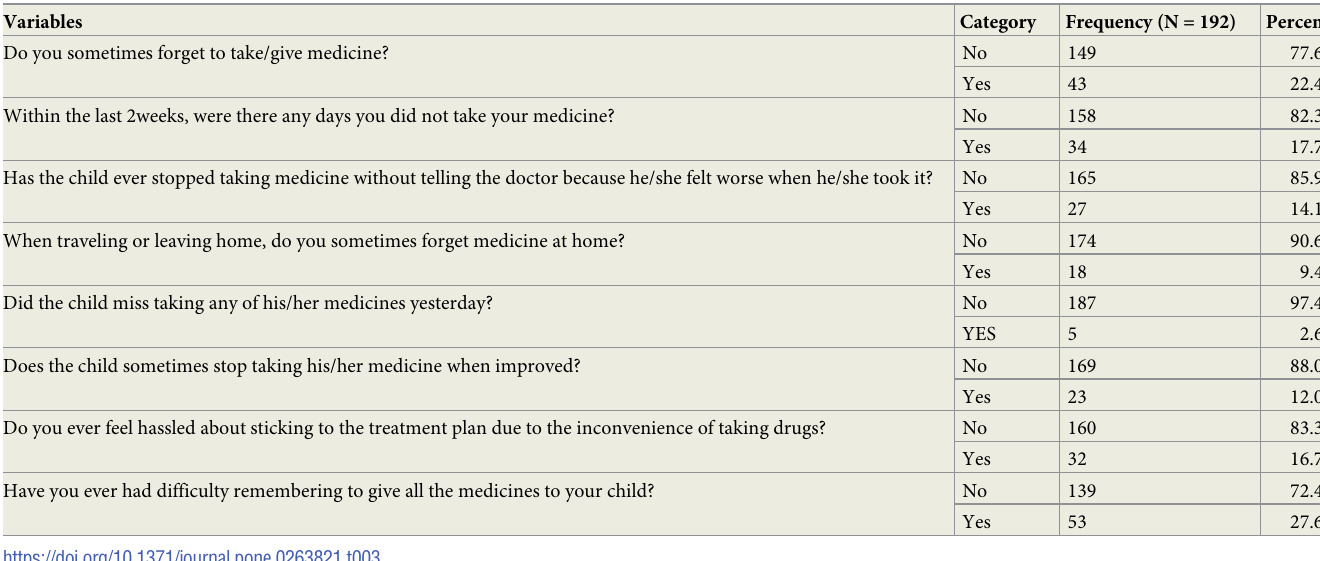
Table 3. Responses to AED adherence assessing items.